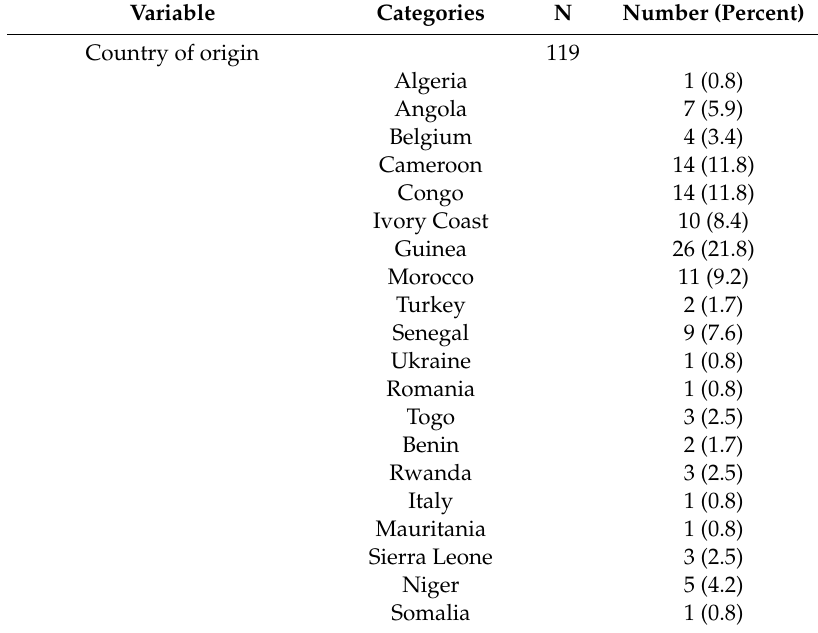
Table 2. Distribution of the 337 cases of tinea capitis by country of origin, history of travels, familial infections, infections acquired in schools, or animal holding.